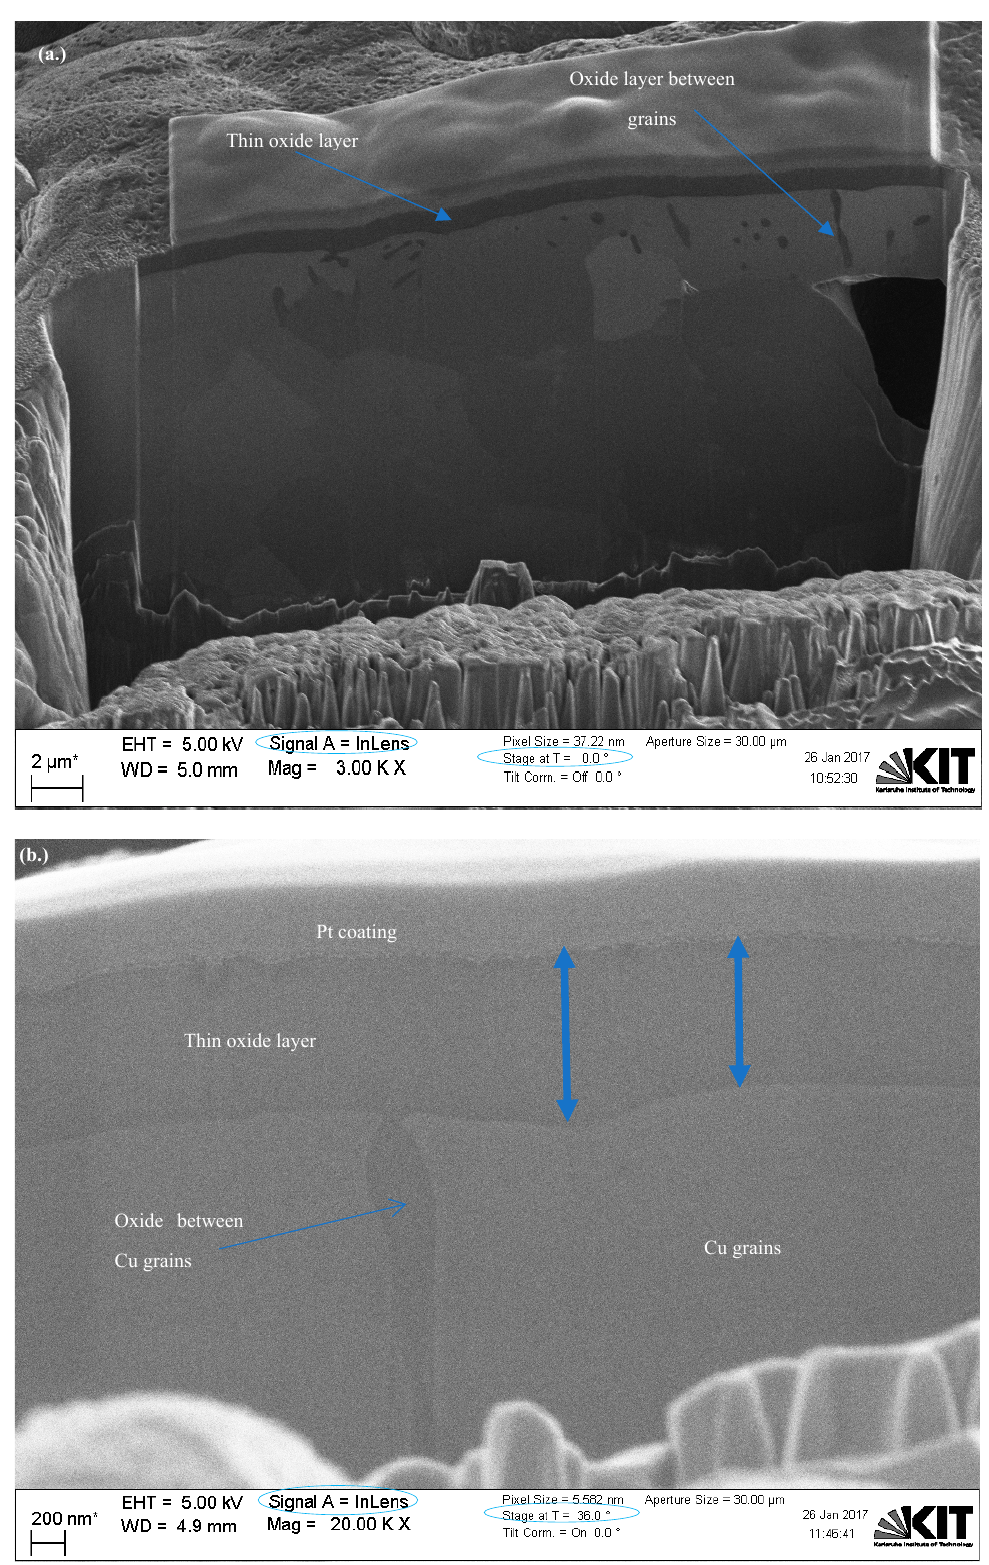
Figure 7. Dual FIB-SEM images of Cu particles with less than 149 µm with a ( a ) 0 ° and ( b ) 36° angle tilt for thin layer measurement.